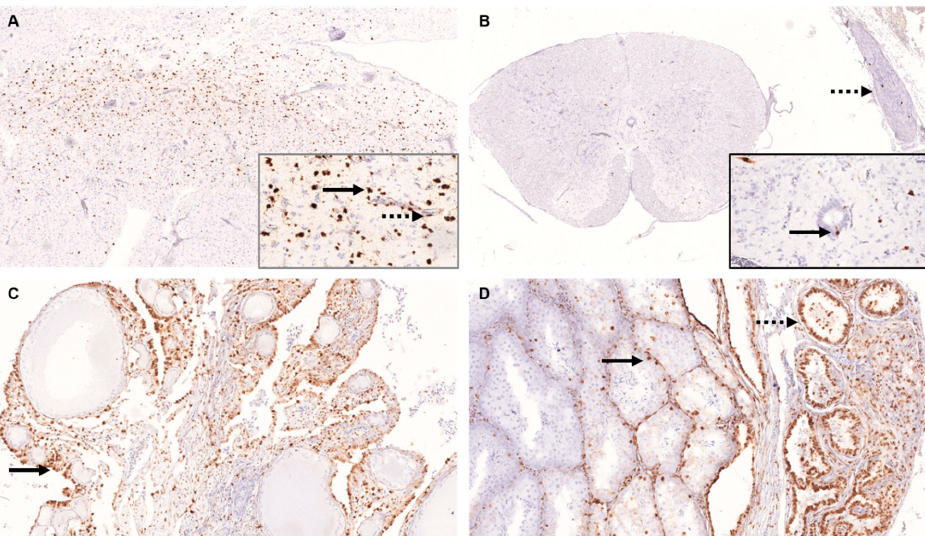
Figure 6. In situ hybridisation (ISH) of tissue of parrot Bornavirus 4 (PaBV-4) infected adult and juvenile cockatiels. ISH was performed by using specific RNA probes to detect sequences encoding for PaBV-4 nucleoprotein (N). ( A ) Brain of adult cockatiel D 1,0. Demonstration of PaBV-4 RNA in neurons (arrow) and endothelial cells (dashed arrow); original magnification x50, magnification of insert × 400. ( B ) Spinal cord and spinal ganglia of adult cockatiel D 1,0. Demonstration of PaBV-4 RNA in neurons, ependymal cells (arrow) and ganglion cells (dashed arrow); original magnification × 50, magnification of insert × 400. ( C ) Ovary of adult cockatiel C 0,1. Demonstration of PaBV-4 RNA in epithelial cells (arrow) and stroma; original magnification × 200. ( D ) Testis and epididymis of juvenile cockatiel J 10. Demonstration of PaBV-4 RNA in testicular spermatogenic cells (arrow) and epithelial cells of the ductus epididymis (dashed arrow); original magnification ×